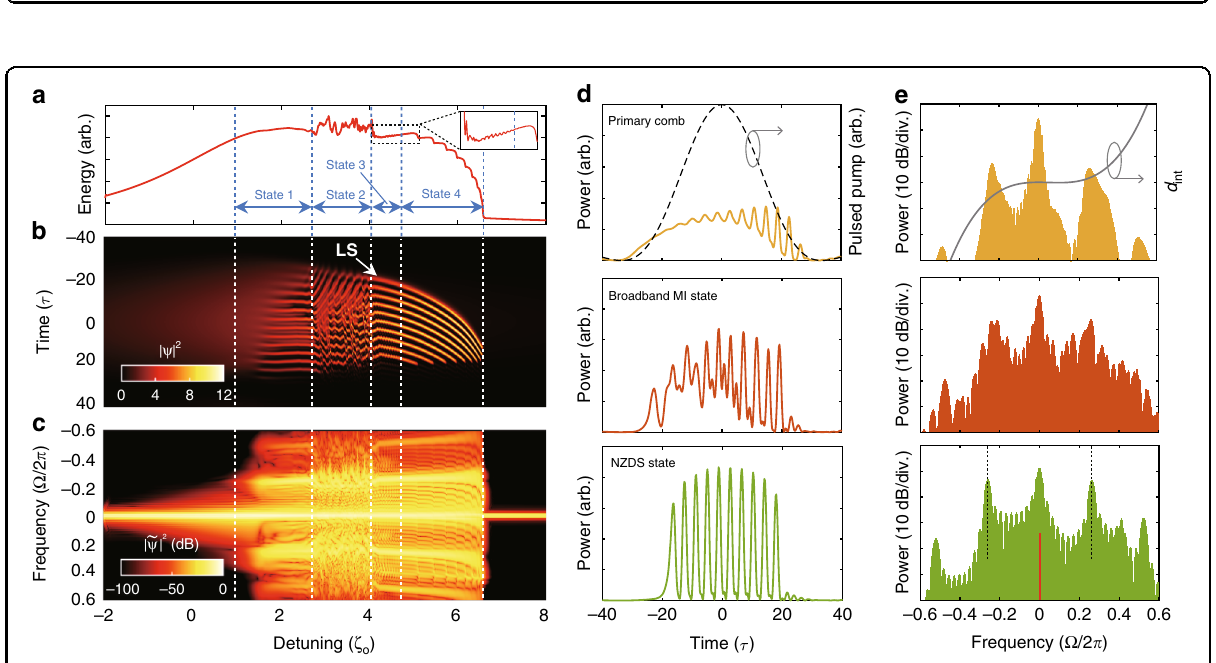
Fig. 1 Conceptual illustration of NZDS generation in a pulse driven F-P microresonator. The upper and lower panels show the temporal waveforms and spectra of NZDSs pumped in the anomalous- and normal-dispersion sides respectively. ZD-HNLF: zero-dispersion highly nonlinear fi ber, HR coating: highly re fl ective